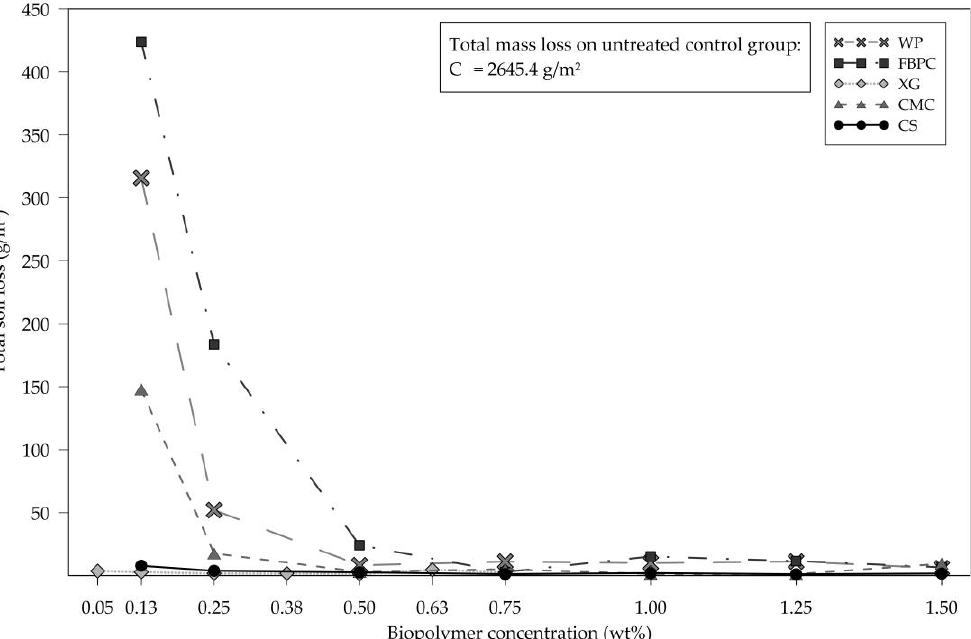
Figure 4. Total soil loss (g/m 2 ) of medium-grained sand samples treated with different biopolymer concentrations. Tests were performed in triplicate (n = 3). Note, numerical data (mean (M) and standard deviation (SD)) are appended in Table A1. Error bars representing the SD have been deliberately omitted for better legibility.